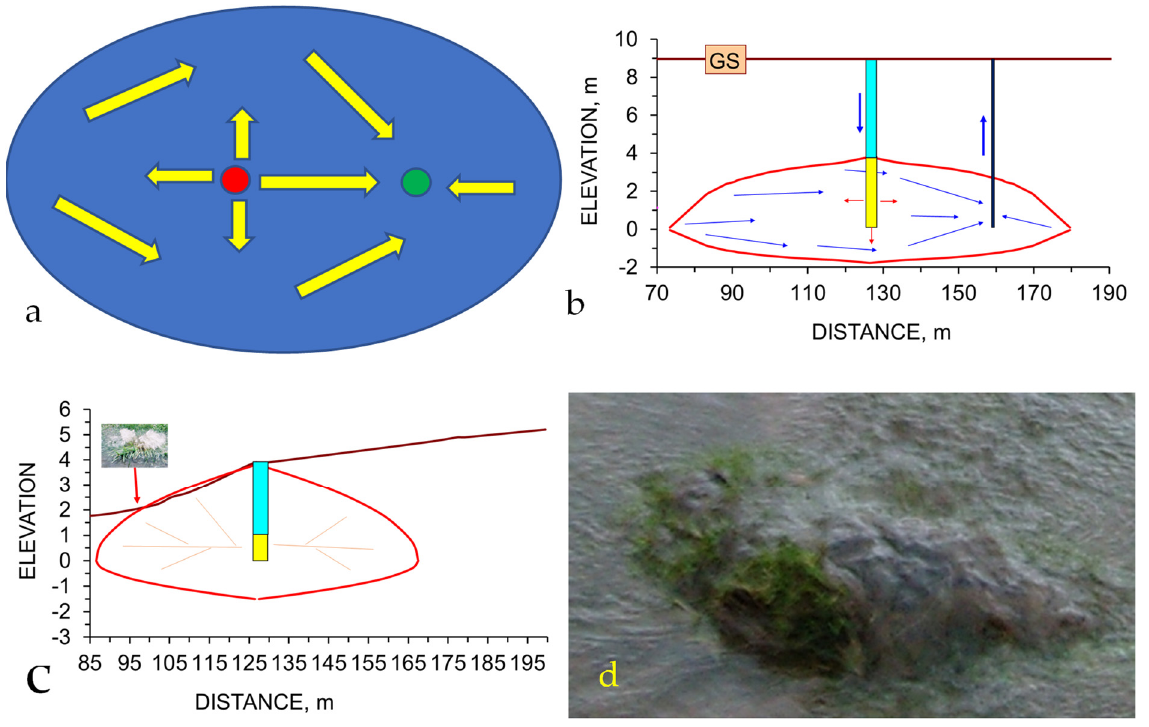
Figure A23. Conceptual groundwater mound being used to simultaneously infiltrate and abstract water. ( a ), plan view; red = infiltration device; green = abstraction well. Yellow arrows = water flow directions, ( b ) cross-sectional view of the groundwater mound. GS = ground surface; red arrows = infiltration flow directions; Blue arrows = abstraction flow directions; yellow = perforated infiltra- tion device; blue = feeder pipes to the infiltration device; purple = abstraction well. ( c ), constructed groundwater mound in clay soil. yellow = perforated infiltration device; blue = feeder chamber to the infiltration device; ( d ), high pressure water discharging, as overland flow, from vertical natural pipes (abstraction point, Figure A23c) within the groundwater mound (field of view = 50 cm).